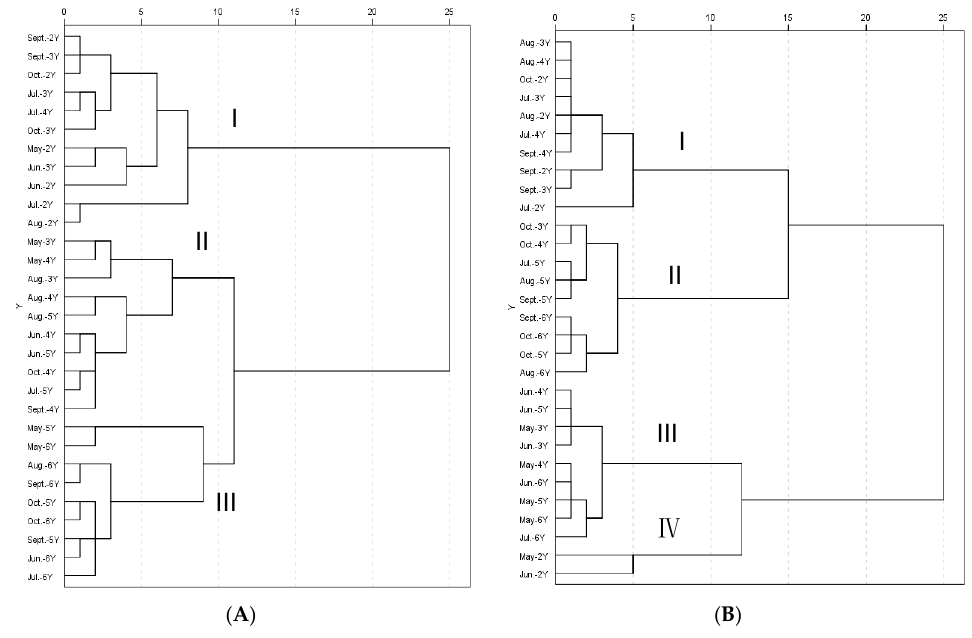
Figure 5. Dendrograms of hierarchical cluster analysis (HCA) using Within-groups linkage. ( A ) HCA was generated from the contents of 11 saponins in the tested samples; ( B ) HCA was generated from the contents of ginsenosides Rg 1 and Re in the tested samples.